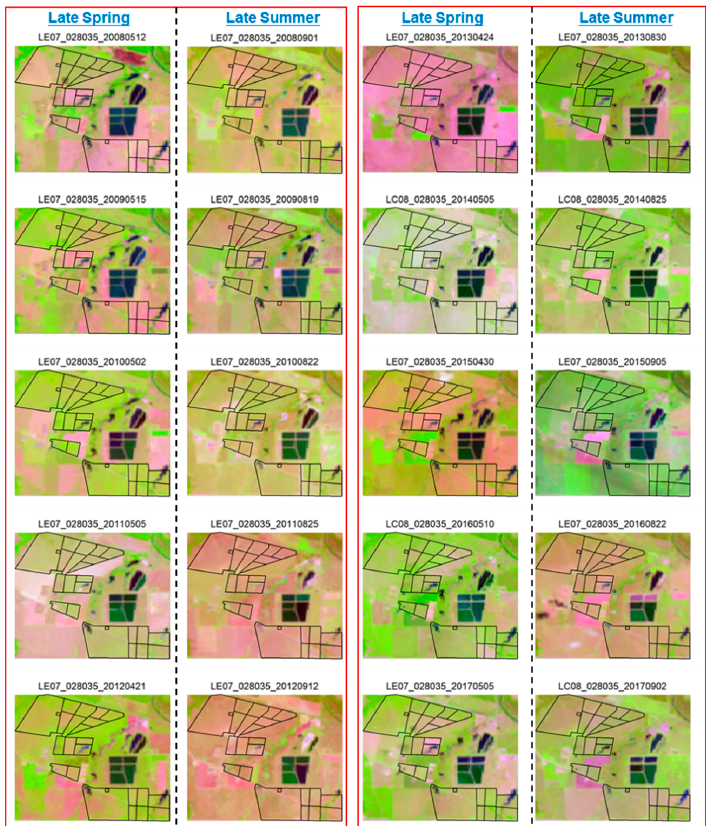
Figure 4. False color composite images (shortwave infrared (SWIR-2), near infrared (NIR), and red bands as RGB) for continuous and rotational grazing paddocks around early May and late August. Green color represents green vegetation and pink or brown color represent dry grasses or soil. The title of each panel includes three parts separated by an underscore: the sensor (LE07 for Landsat 7 ETM + and LC08 for Landsat 8 OLI / TIRS combined), the path / row number, and acquisition date of the